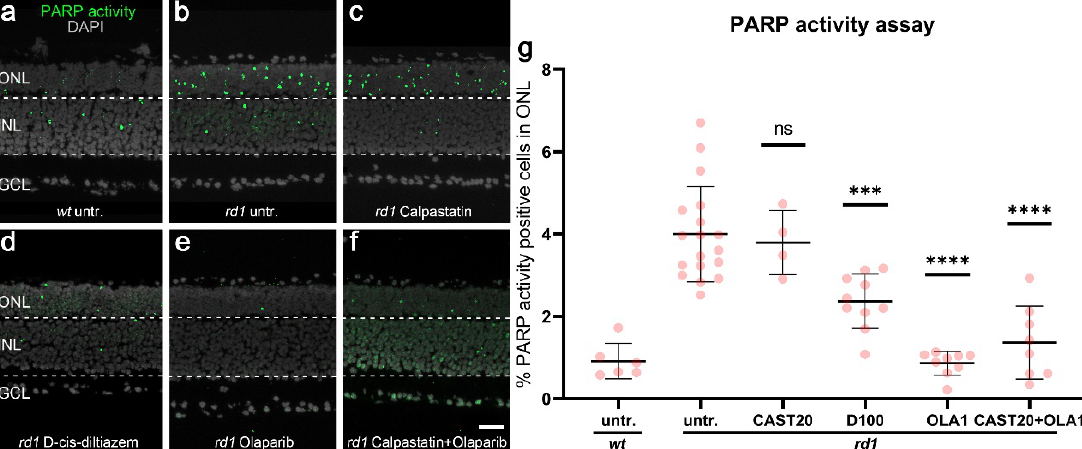
Figure 2. Effects of calpastatin, D-cis-diltiazem, Olaparib, and combination treatments on PARP activity. PARP activity assay (green) in wt and rd1 retina. DAPI (grey) was used as nuclear counter- staining. Untreated wt (untr.; a ) was compared to untreated rd1 retina ( b ) and retinae treated with either calpastatin ( c ), D-cis-diltiazem ( d ), Olaparib ( e ), or calpastatin and Olaparib combined ( f ). The scatter plots show the percentages of the outer nuclear layer (ONL) cells positive for PARP activity ( g ) in wt and rd1 retina. Statistical significance was assessed using one-way ANOVA and Tukey’s multiple comparison post hoc testing performed between the control ( rd1 untreated) and 20-µM calpastatin (CAST20), 100-µM D-cis-diltiazem (D100), 1-µM Olaparib (OLA1), and 20-µM calpastatin combined with 1-µM Olaparib (CAST20+OLA1). Calpastatin did not reduce the PARP ac- tivity, while D-cis-diltiazem and Olaparib did. Untr. wt : 6 explants from 3 different mice; untr. rd1 : 18/18; CAST20 rd1 : 4/4; D100 rd1 : 10/10; OLA1 rd1 : 9/9; CAST20+OLA1 rd1 : 8/8; error bars represent SD; ns = p > 0.05, *** = p ≤ 0.001 , and **** = p ≤ 0.0001. INL = inner nuclear layer, GCL = ganglion cell layer. Scale bar = 50 µm.